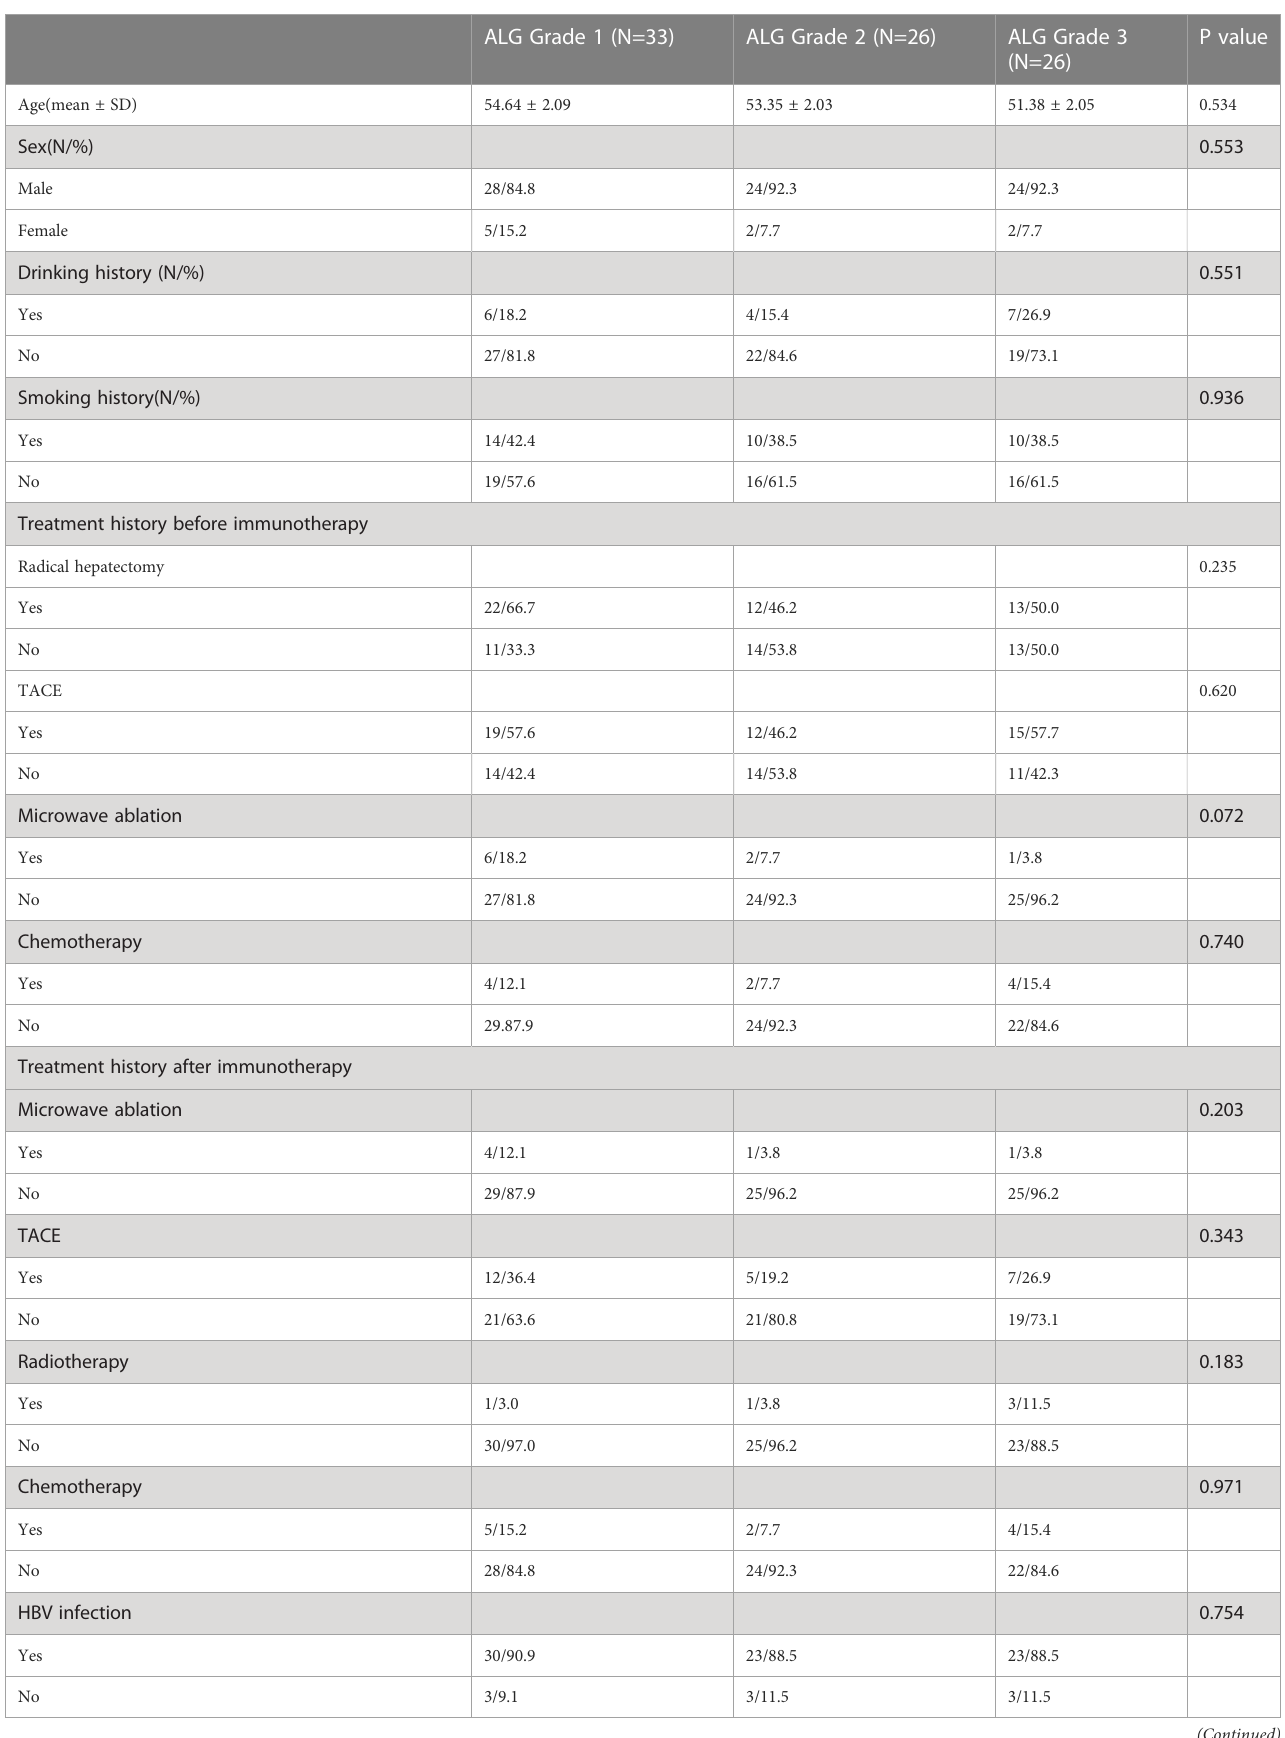
TABLE 1 Demographic characteristics of 85 patients with HCC who received